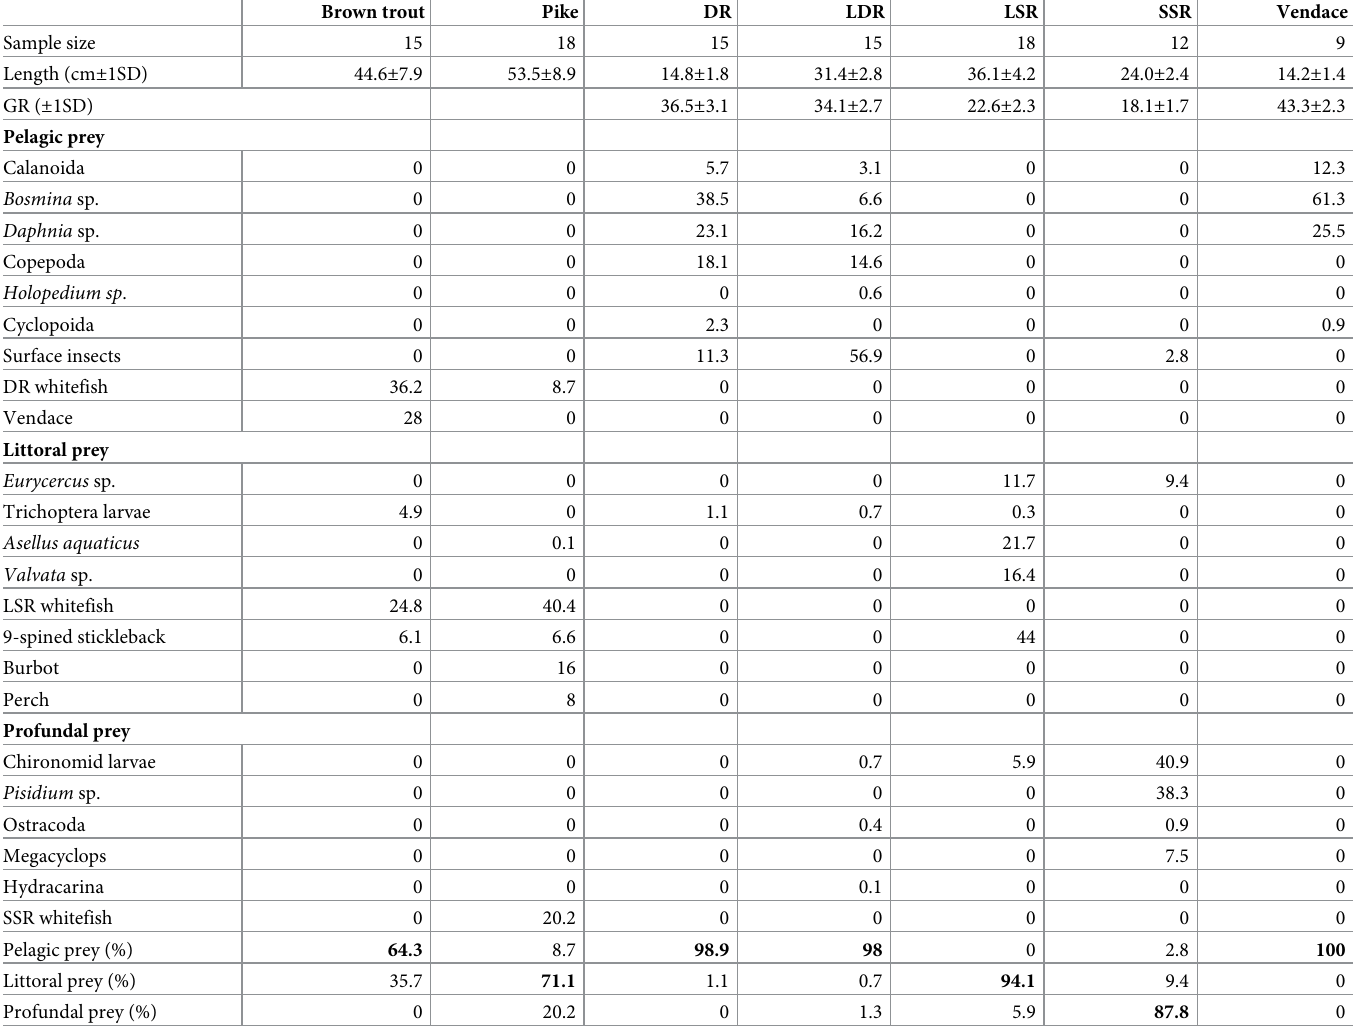
Table 1. Sample sizes, total length, gill raker number (GR) and diet of selected fish taxa in lakes of the Paatsjoki watercourse (DR = densely-rakered whitefish, LDR = large densely-rakered whitefish, LSR = large sparsely-rakered whitefish, SSR = small sparsely-rakered whitefish). Diet is divided into littoral, pelagic and pro- fundal groups, with the main prey group for each species and morph highlighted in bold (these values were used as diet priors in subsequent stable isotopes mixing